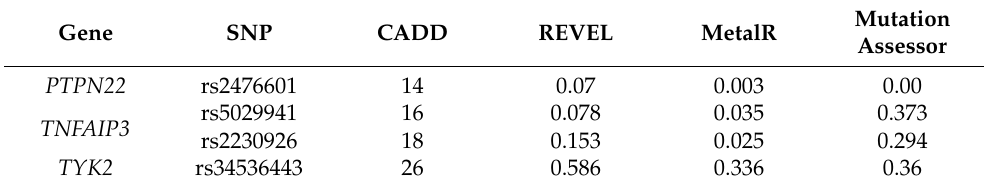
Table 3. Ensembl results for the selected four nsSNPs. Gene SNP